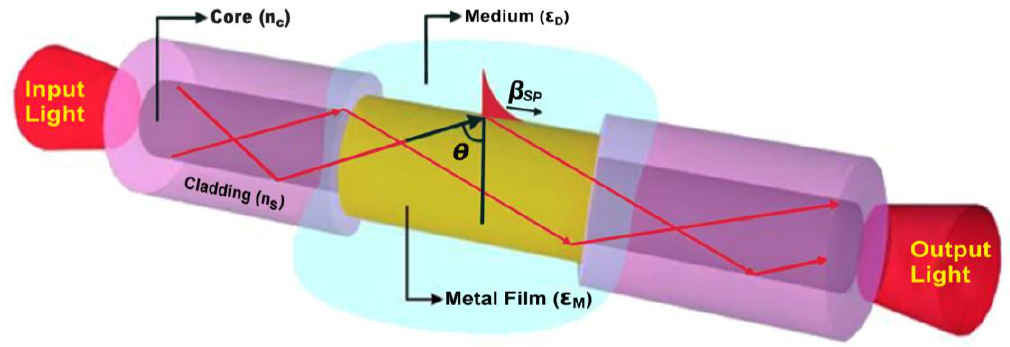
Figure 6. SP excitation using optical fiber structure.